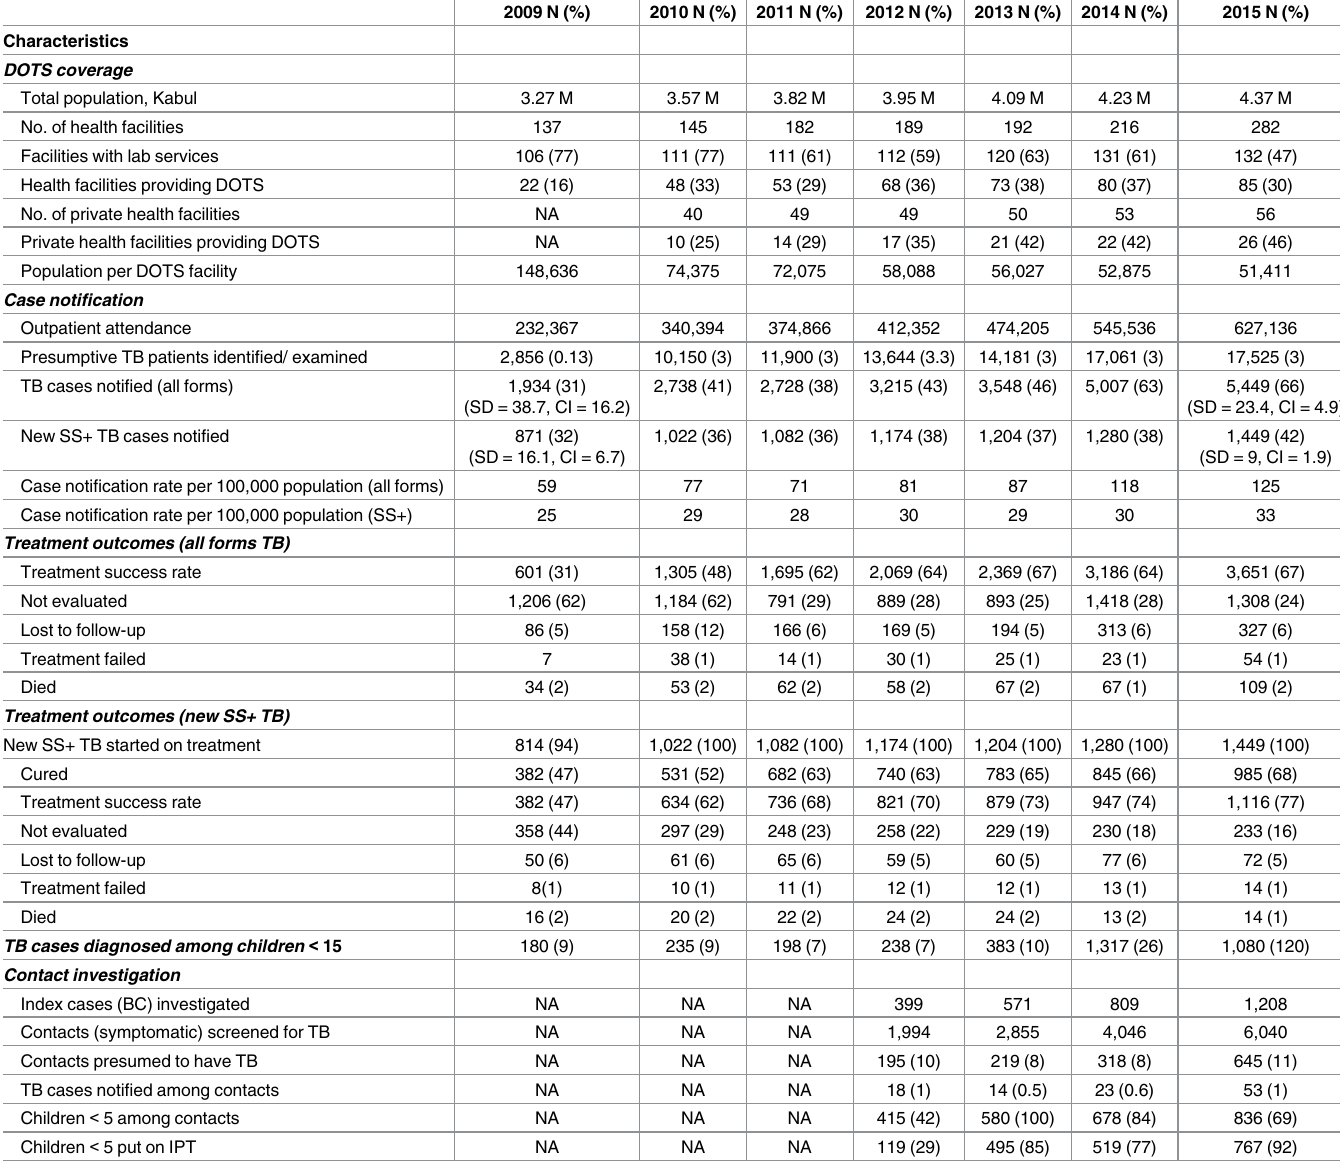
Table 1. Contribution of urban DOTS to TB servicedelivery in Kabul city,